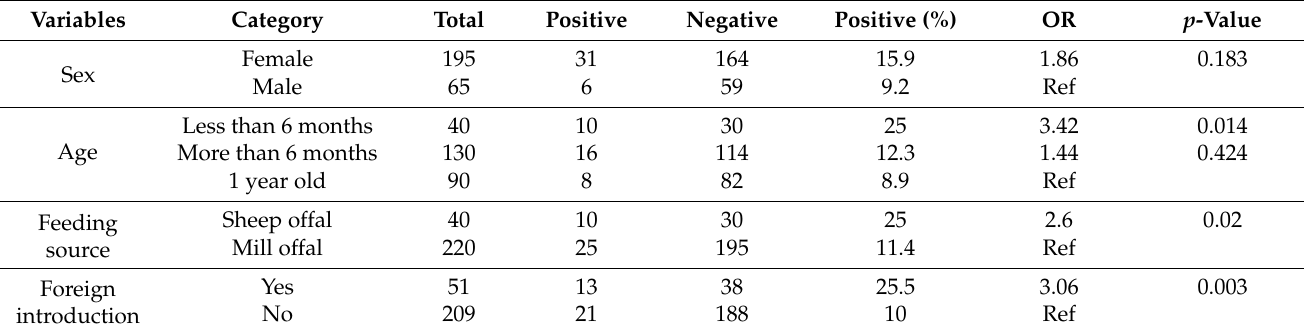
Table 3. Risk factor analysis of HEV in farm pigs in Ulaanbaatar